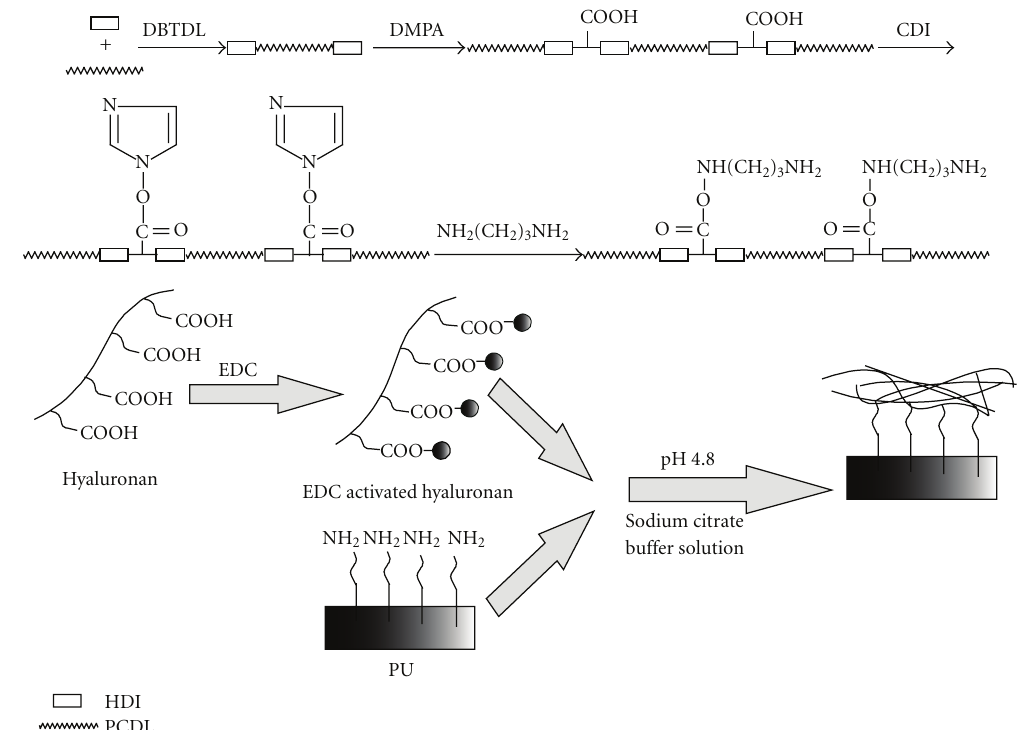
Figure 1: Synthesis of HA-immobilized PU